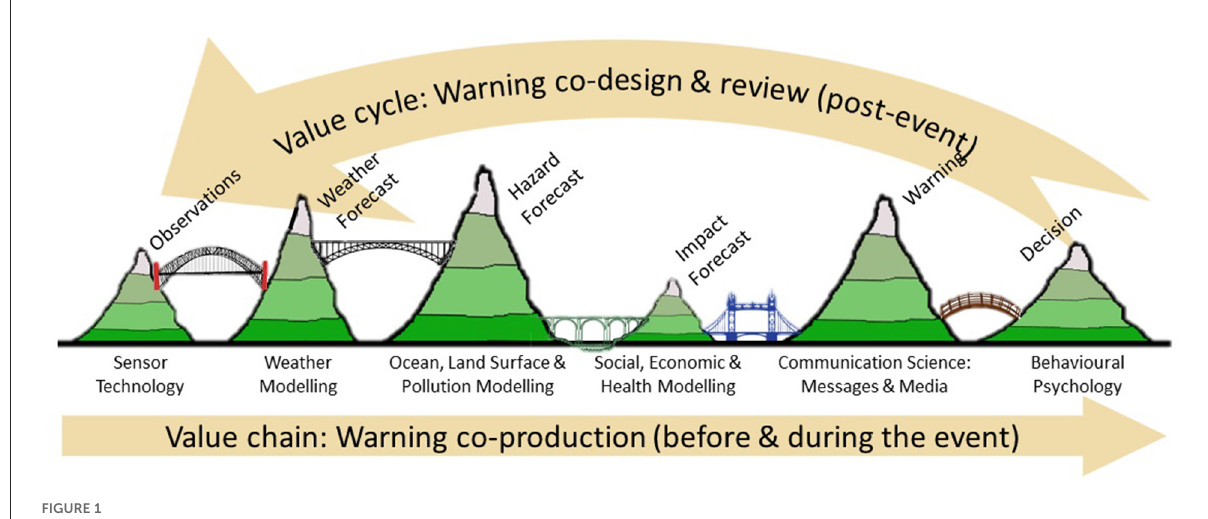
FIGURE1 The warning value chain concept proposed by Golding et al. (2019),